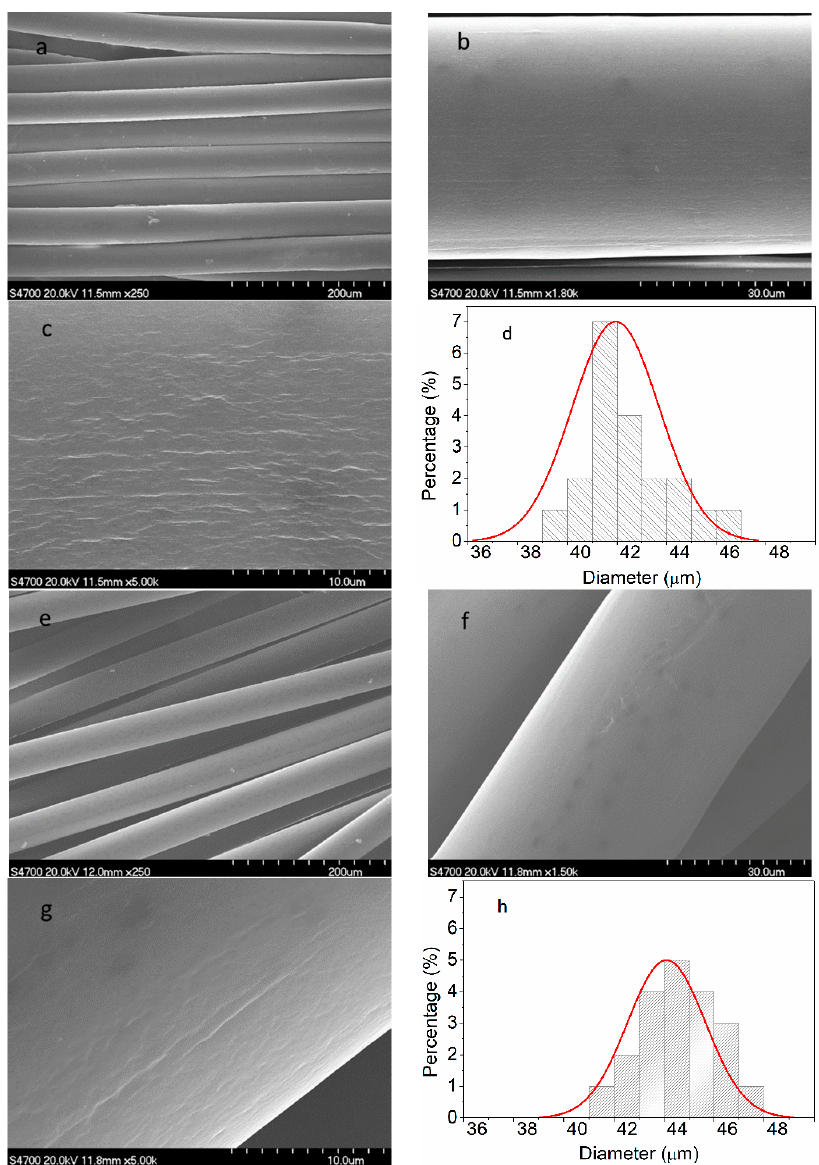
Figure 9. SEM images of surface morphology and corresponding diameter distribution: ( a – d ) the PAN nascent fibers and ( e – h ) the grafted MWCNT/PAN nascent composite fibers. nascent fibers and ( e – h ) the grafted MWCNT/PAN nascent composite